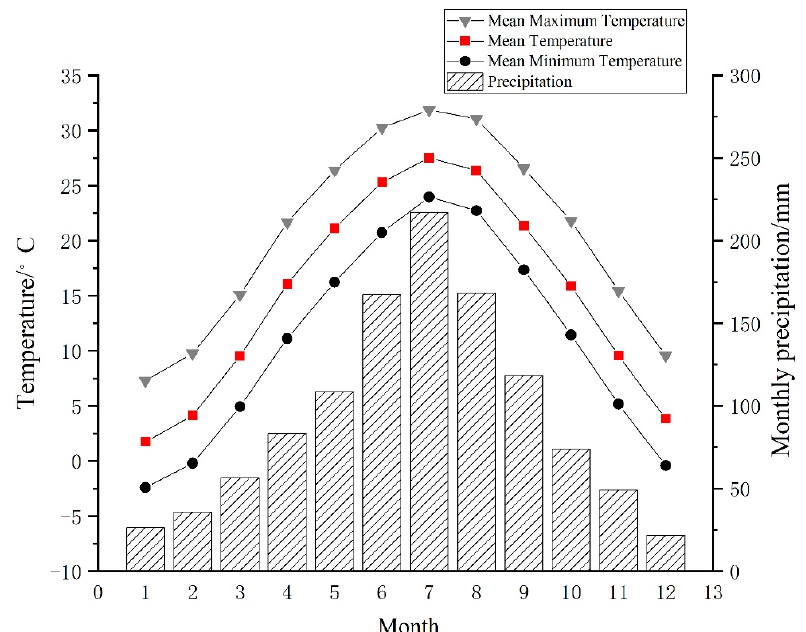
Figure 3. The distribution graph of monthly mean temperature (T), mean maximum temperature (Tmax), mean minimum temperature (Tmin) and monthly total precipitation (P) at the Tongbai meteorological station from 1958–2014.